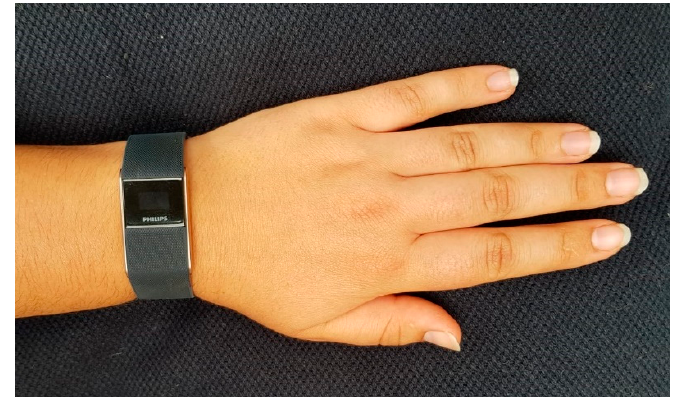
Figure 1. The Philips Data Logger (worn on the author’s hand). This device will be employed in this study to acquire PPG and accelerometer data. The device does not display this PPG and accelerometer data, it only displays the time.